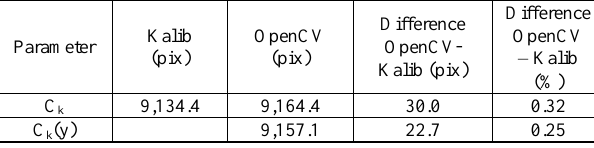
Table 4. Calibrated Camera Constant.